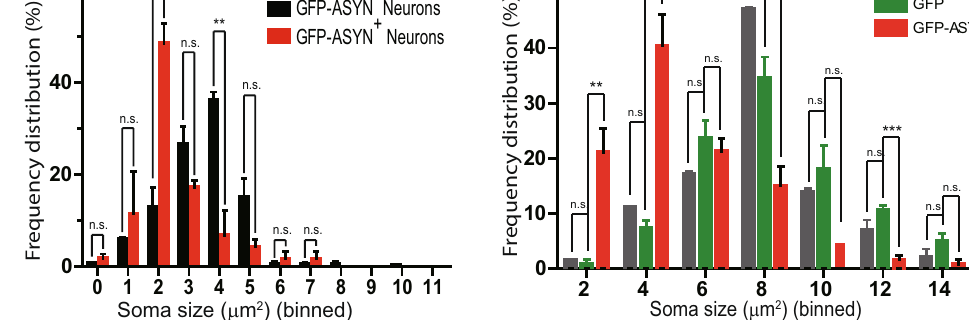
Figure 6. Increased level of ASYN induced cortical neuronal atrophy. E18 cortical neurons from either Line 78 ( A , B ) were dissected and cultured as in Fig. 1. At DIV7, the cultures were analyzed by microscopy. Both GFP and phase contrast images were captured and merged. As shown in A , not all neurons expressed ASYN- GFP. The soma sizes of GFP-positive neurons (n = 40) and GFP-negative neurons (n = 112) were measured in ImageJ. Histogram analysis of the size distribution of GFP-positive versus GFP-negative neurons is shown in B . In C , D , rat E18 cortical neurons were dissected and cultured as described in Materials and methods. Neurons were transfected with either GFP or ASYN-GFP using LipoFectamine2000. The cultures were analyzed by microscopy 72 hrs post transfection. Both GFP and phase contrast images were captured and merged ( C ). The soma sizes of untransfected neurons (n = 188), GFP-positive neurons (n = 122) and ASYN-GFP neurons (n = 127) were measured in ImageJ. Histogram analysis of the size distribution of untransfected, GFP-positive and ASYN-GFP neurons is shown in D . The differences between ASYN-GFP and untransfected neurons and between ASYN-GFP and GFP neurons are highly significant ( *** ), while the difference between untransfected and GFP neurons is not significant (One-Way ANOVA with Bonferroni’s